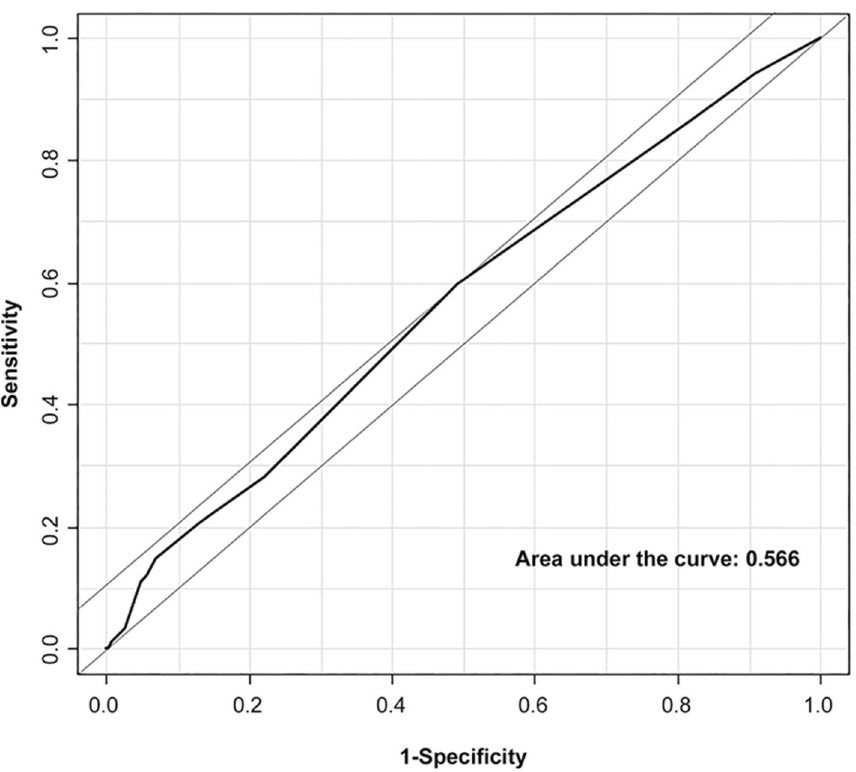
Figure 5. Receiver-operating characteristic plots to estimate the threshold of the Charlson Comorbidity Index associated with 30-day